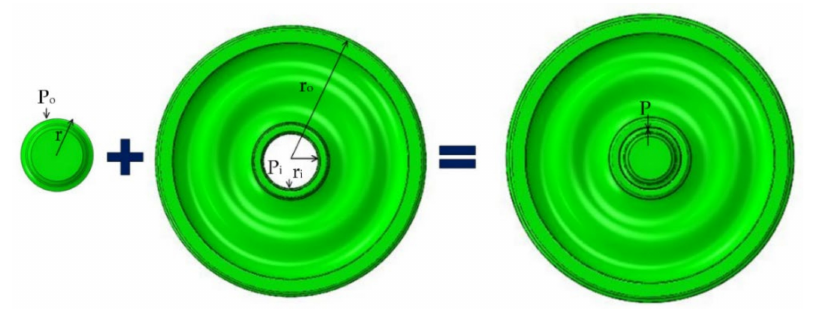
Figure 1. Assembly of an axle and a